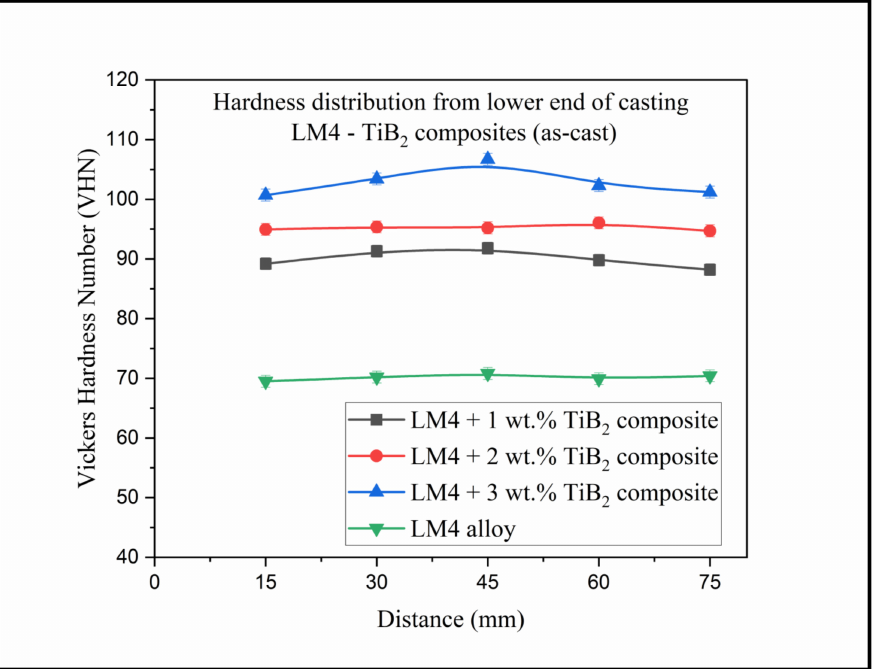
Figure 9. Hardness distribution graph from the lower end of the cast LM4 alloy and its composites. For 1600 g of LM4 alloy, 48 g (3 wt.%) of TiB 2 was added during stir-casting. The